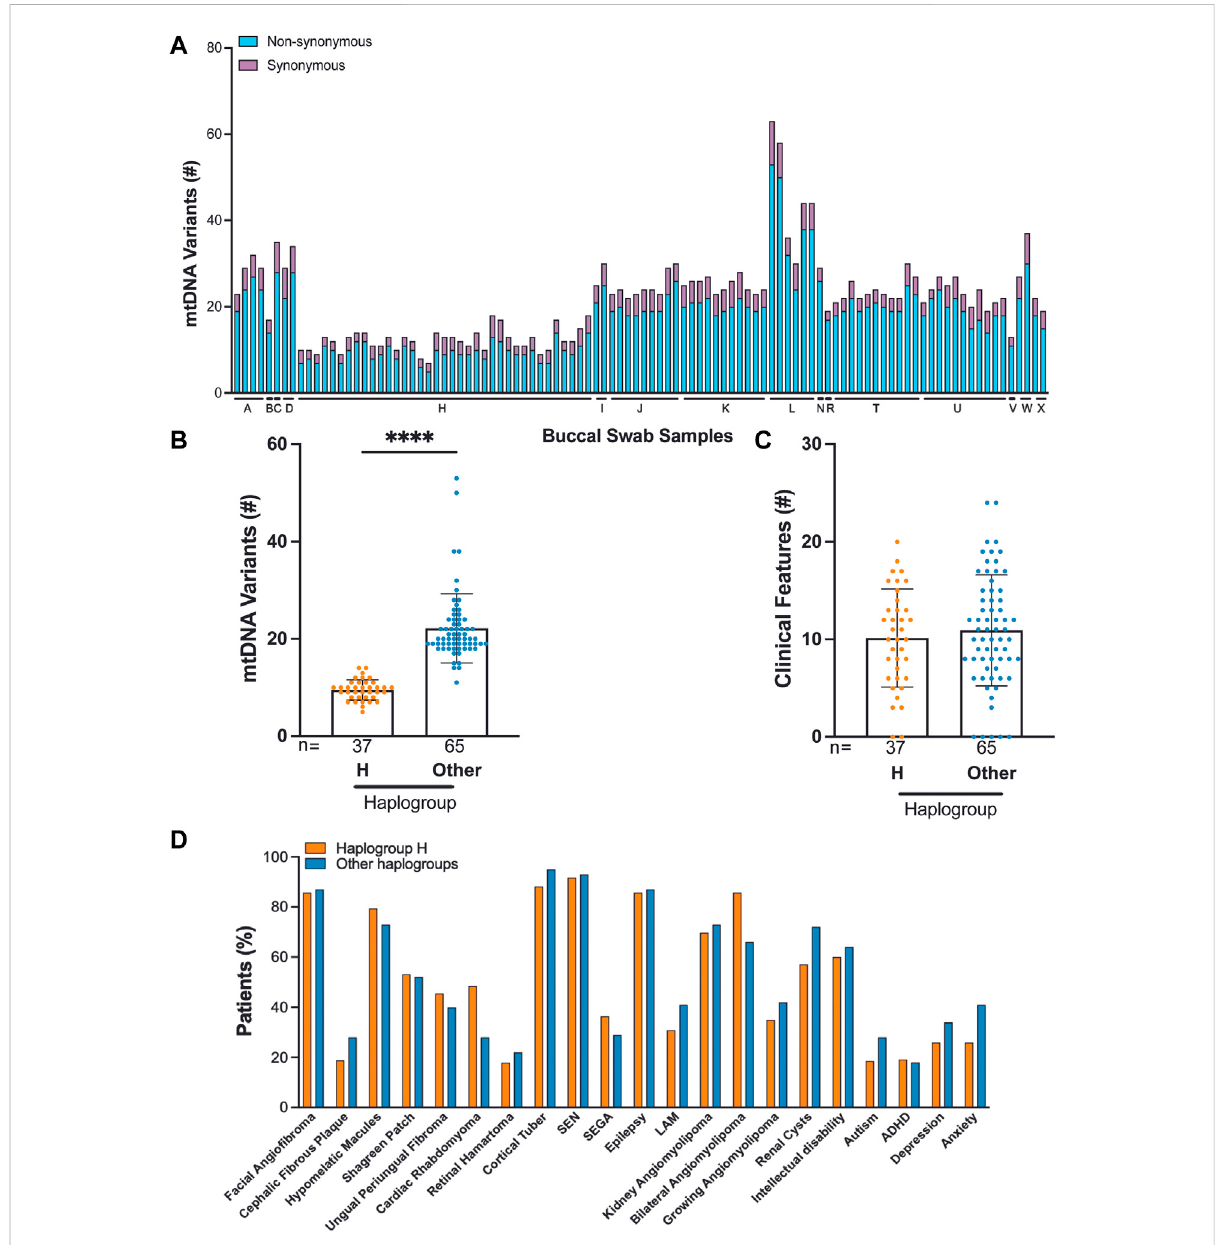
FIGURE 3 Correlation of TSC-associated clinical features and mtDNA haplogroup analysis from 102 buccal swabs. (A) Distribution of synonymous and non-synonymous variants in TSC individuals according to their haplogroup. (B) Number of mtDNA variants in haplogroup H compared to all other haplogroups. (C,D) The frequency of 22 clinical features in patients from haplogroup H compared to all other